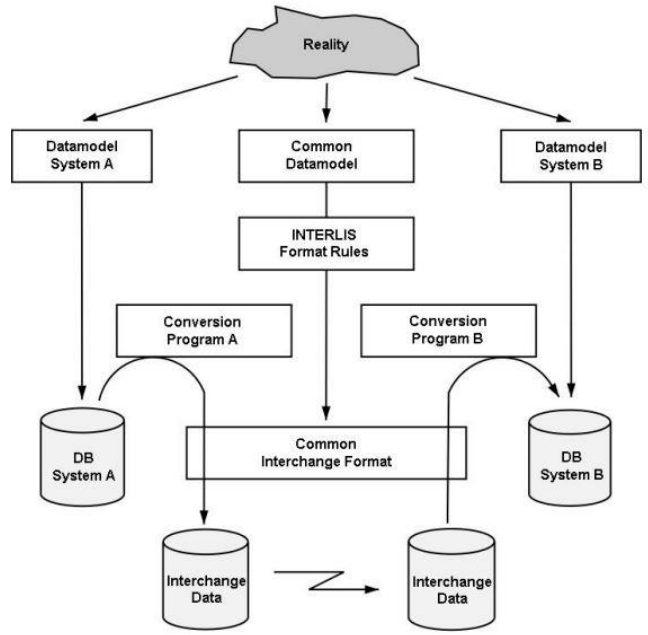
Figure 5. Data transfer between several databases via a common data model (data schema) described in a common data description language [69].